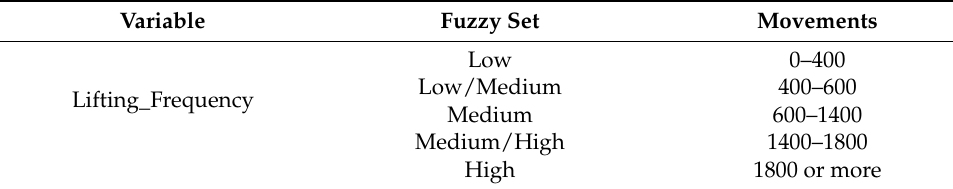
Table 8. Ranges of Work_Conditions and their fuzzy sets.